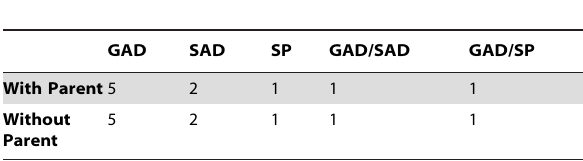
Table 1. Frequencies for diagnoses of anxious youths in each group (matched by